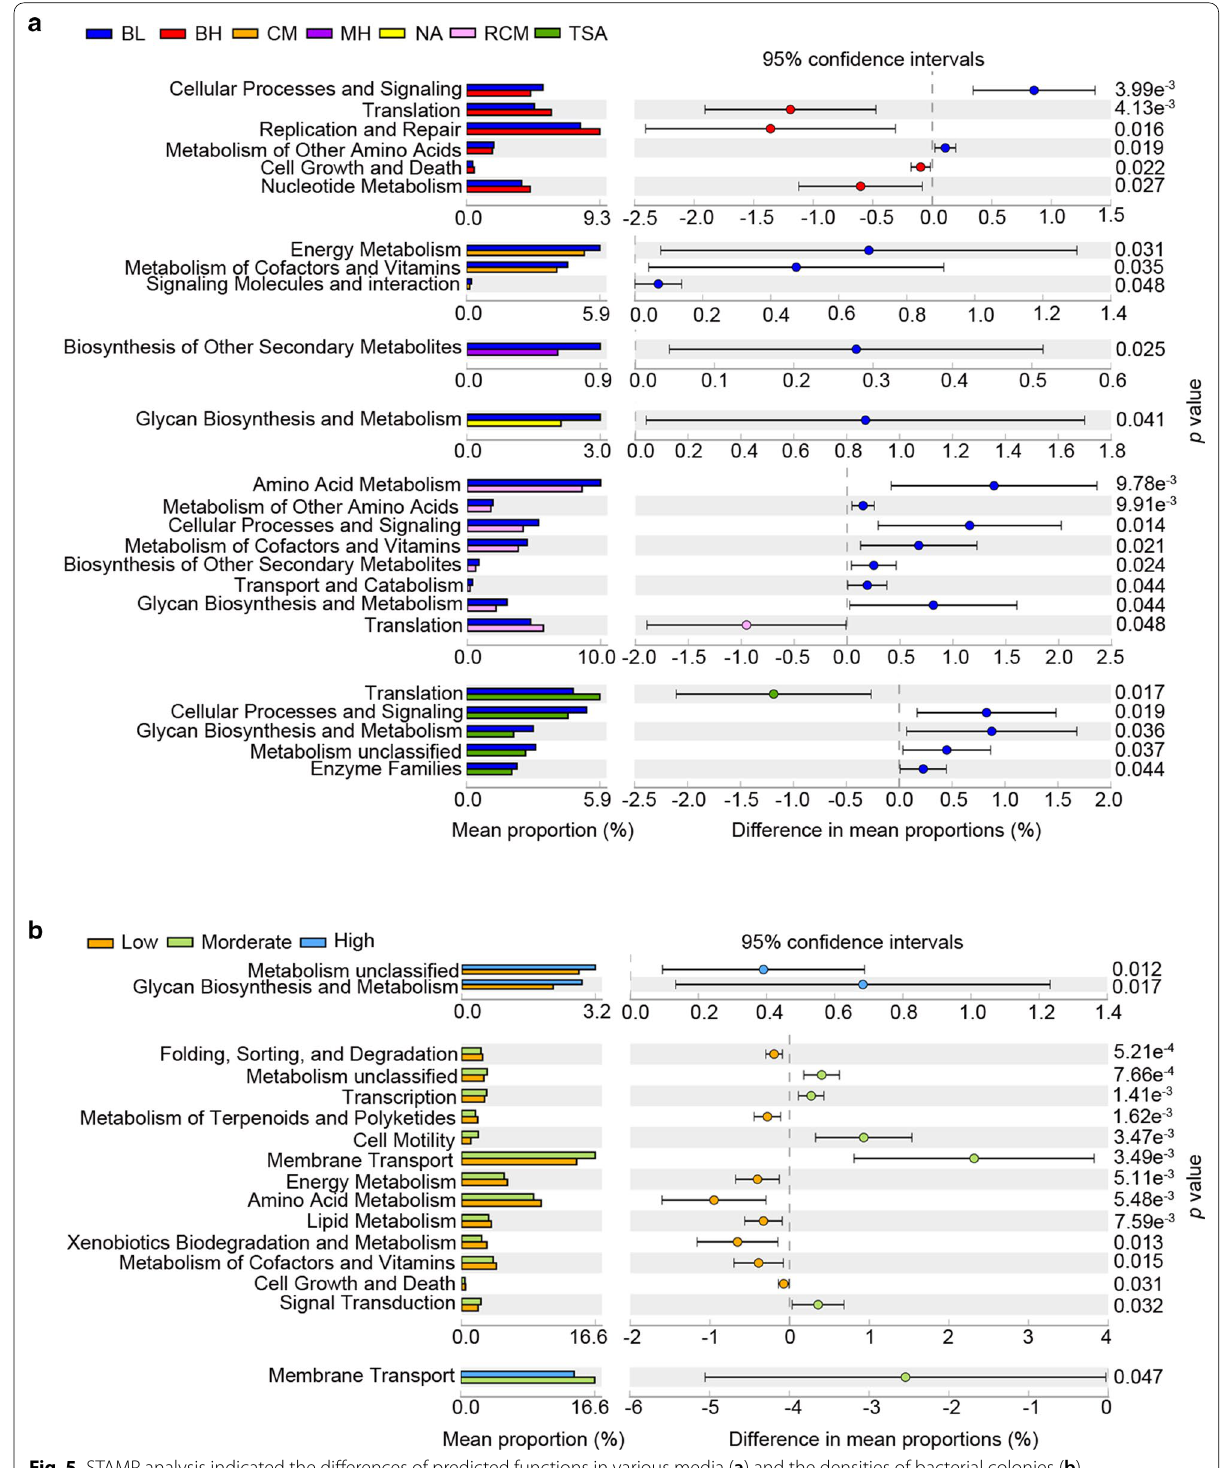
Fig. 5 STAMP analysis indicated the differences of predicted functions in various media ( a ) and the densities of bacterial colonies ( b